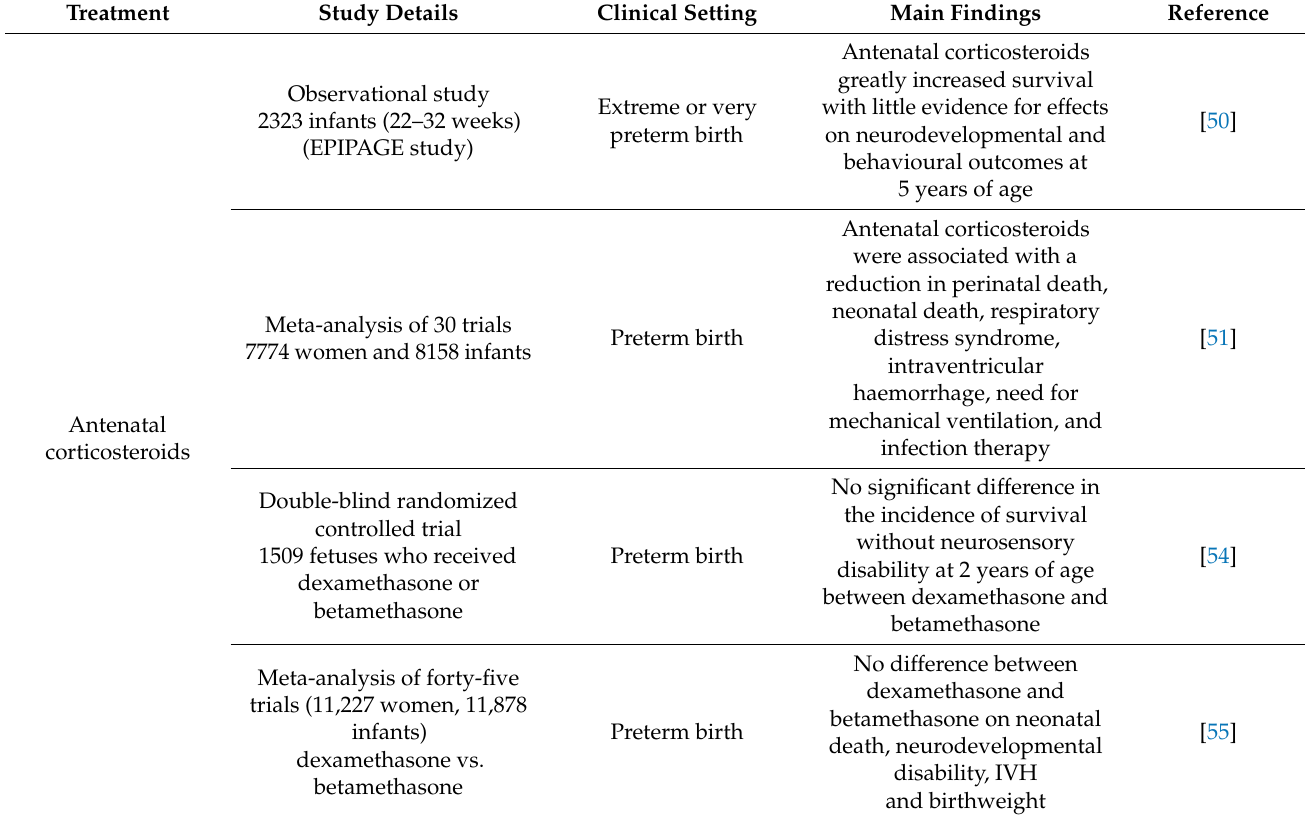
Table 1. Summary of key clinical studies discussed in this review investigating the neurological effects of current and potential neuroprotective treatments in preterm infants. Treatment Study Details Clinical Setting Main Findings